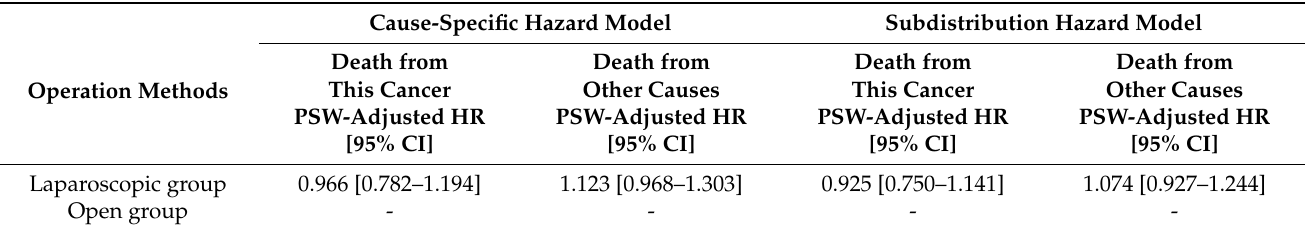
Table 4. Results of competing risk analysis of patients treated with open surgery vs.